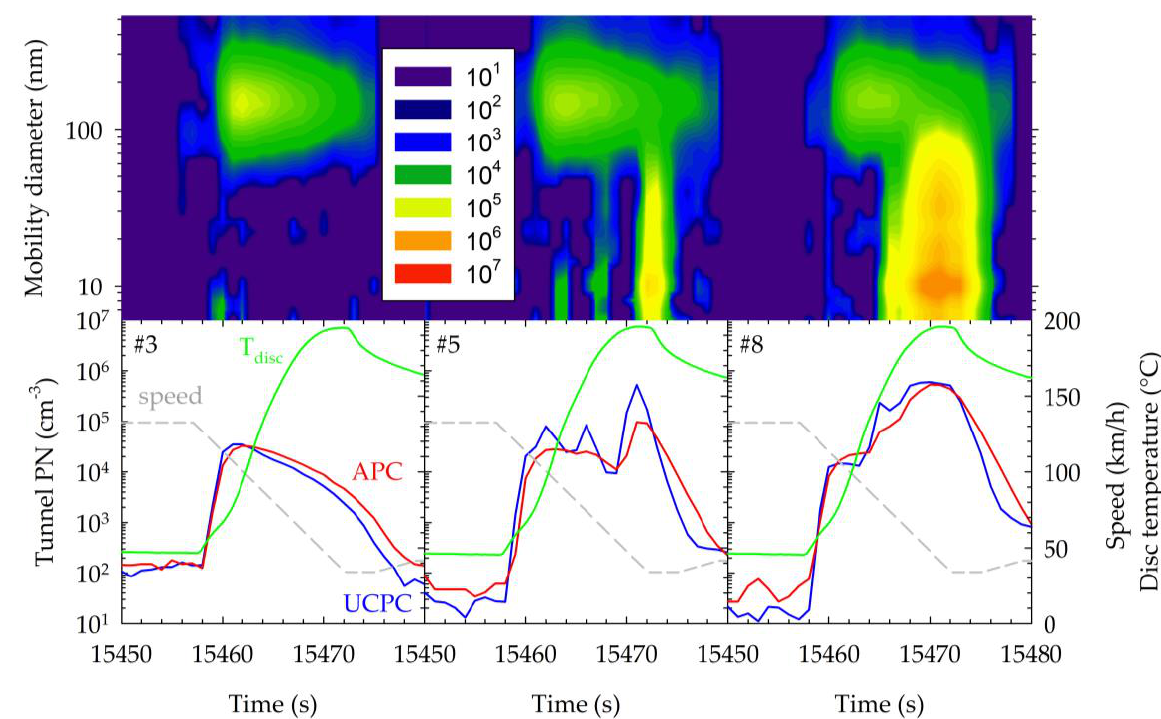
Figure 6. Top panel: PN size distributions of untreated tunnel samples over the 295th brake event measured with the EEPS over the 3rd ( left-most panel ), the 5th ( middle panel ) and 8th ( right-most panel ) repetition of the WLTP procedure during degreening of fresh pads (Figure 3). Bottom panel: corresponding speed (grey lines), disc temperature (green lines) and real time PN concentration traces for thermally treated (red lines—APC) and untreated (blue lines—UCPC) samples.